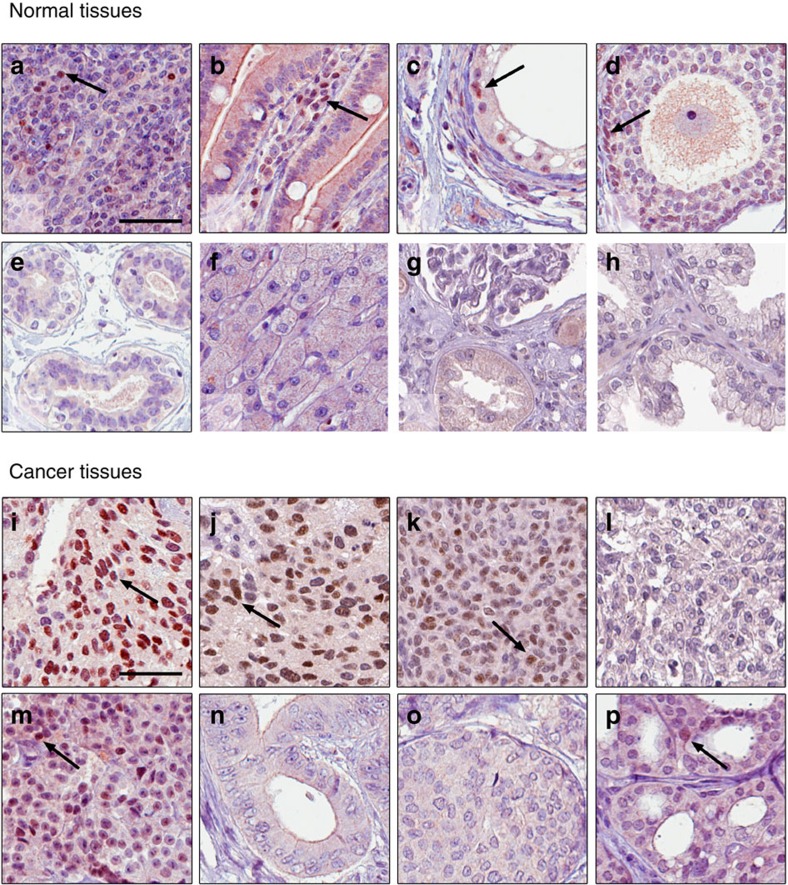
ERβ tissue profiling using antibody PPZ0506.IHC profiling of normal tissues (top panel) and cancer tissues (lower panel). Nuclear ERβ positivity using PPZ0506 (dilution 1:600) is identified in normal tissues of (a) tonsil, (b) peripheral inflammatory cells (small intestine), (c) testis and (d) ovary. No IHC positivity was seen in (e) breast, (f) liver, (g) kidney, or (h) prostate. Nuclear ERβ positivity is identified in cancerous tissues (i–l) three out of four granulosa cell tumours, (m) one case of melanoma, and (p) one case of thyroid cancer. The remaining 16 cancer types were all IHC-negative, here exemplified by (n) colorectal cancer and (o) breast cancer. Brown: positive IHC staining; Blue: hematoxylin counter staining. BC: breast cancer. Scale bar indicates 50 μm. Arrows indicate examples of cells with nuclear staining.